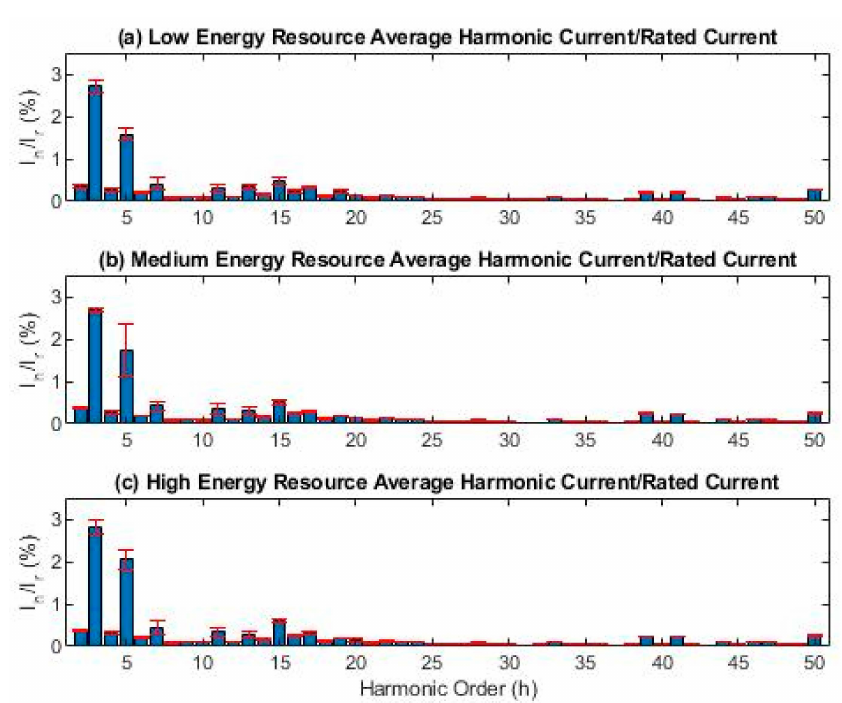
Figure 6. Sea trial average ratios of harmonic current amplitude to rated current for ( a ) low energy, ( b ) medium energy, and ( c ) high energy resource classifications, including error bars, which represent the standard deviation of the data